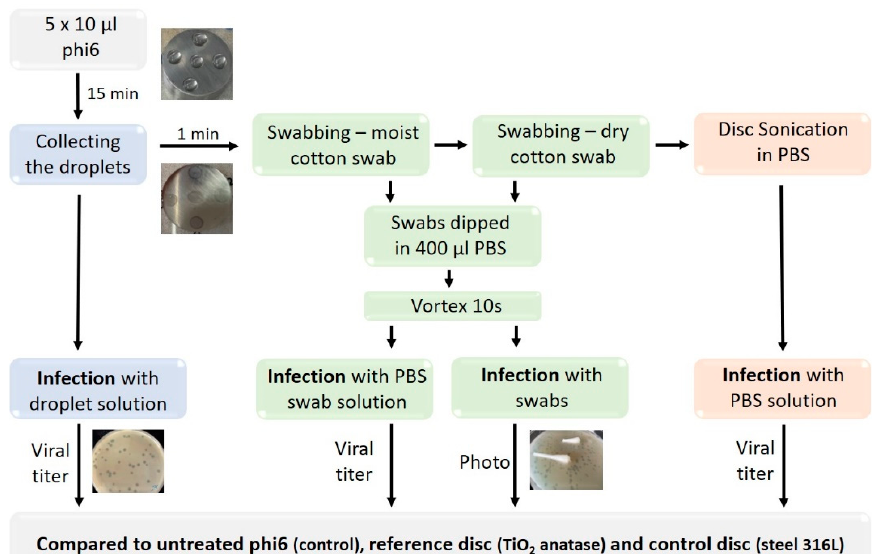
Figure 1. Schematic representation of disk testing.